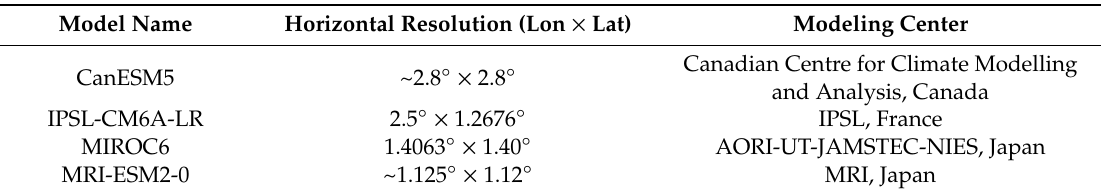
Table 1. Summary of the four Coupled Model Intercomparison Project (CMIP6) models used in this